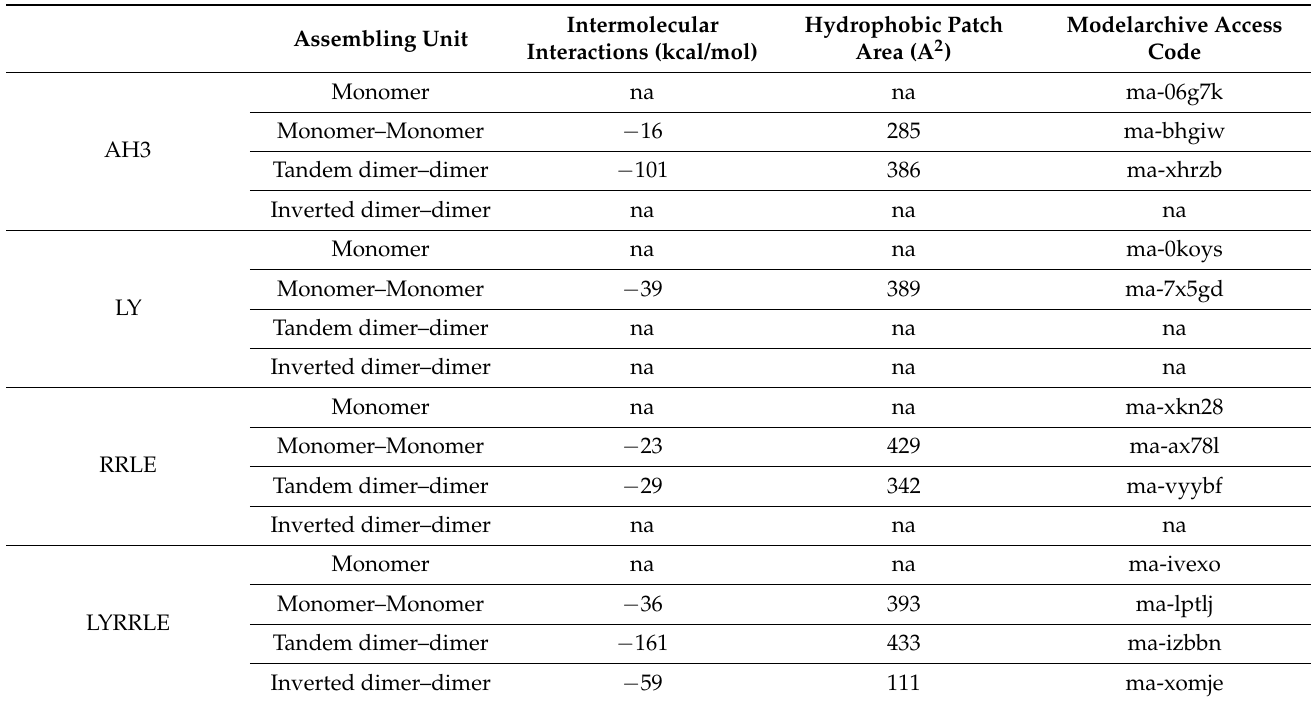
Table 1. List of intermolecular forces and the access code of protein models deposited in Mode-